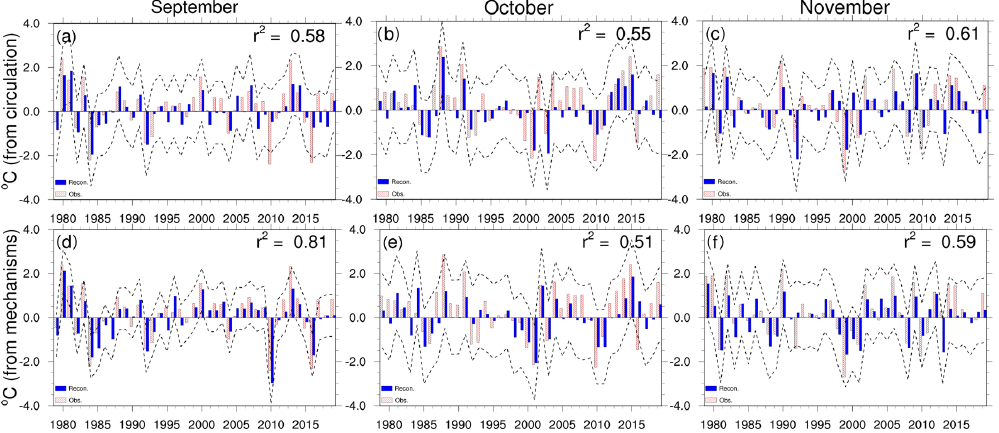
Figure 6. As in Fig. 4g–i but using time series of key circulation features (southwest low, southeast low, and southern Australian anticyclone) identified in Figs. 1 and 2 as predictors in the top row (a–c) and area-averaged dynamical heat mechanism components (850hPa zonal wind and meridional wind (multiplied by − 1) and 500hPa vertical motion; see text for region averaged over) as predictors in the bottom row (d–e) for September, October, and November.